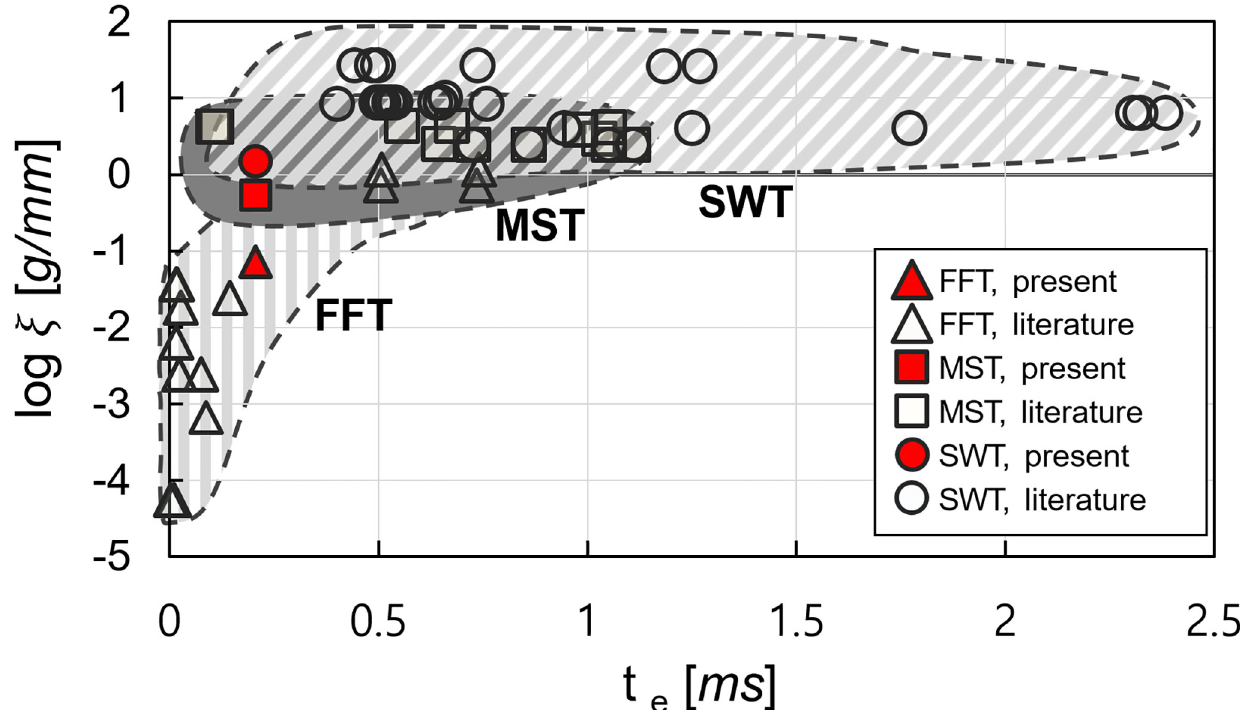
Fig 14. Range of size factor and flow establishment time for each technique. The FFT data obtained from Refs. [6, 10, 11, 48–50]; the MST data obtained from Refs. [7, 12, 13, 22, 24, 51, 52]; the SWT data obtained from Refs. [8, 9, 15, 22, 43–45, 53].